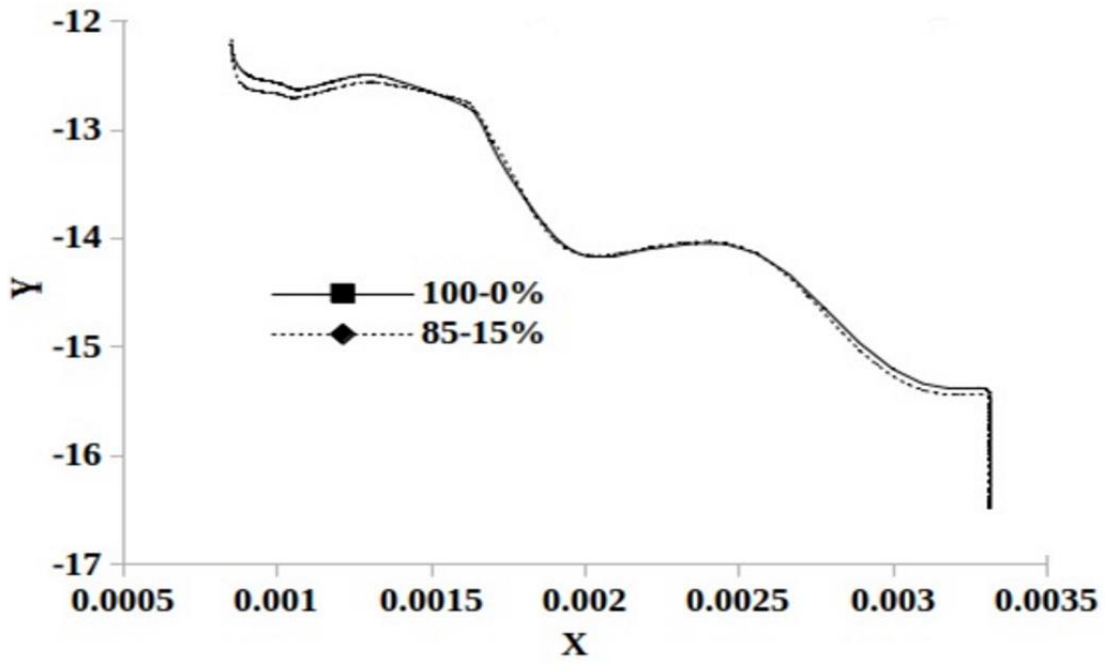
Figure 6. Kinetic analysis during the thermal decomposition of the 85%-15% and 100%-0% samples. The activation energy is calculated from the slope of linear trends.